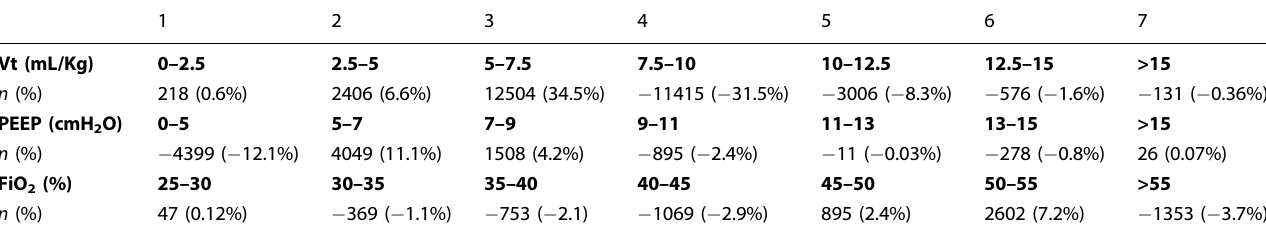
Speci fi c setting ranges for the action space bins are highlighted in grey for Vt, FiO 2 and PEEP, respectively. Data is presented in total numbers and relative percent of the total numbers of actions chosen (36,225 total decision time instances). Positive numbers indicate that an action has been chosen more frequently by VentAI, negative numbers indicate that an action has been chosen less frequently. Vt: Tidal Volumes; FiO 2 : Fraction of inspired oxygen; PEEP: positive end-expiratory pressure.